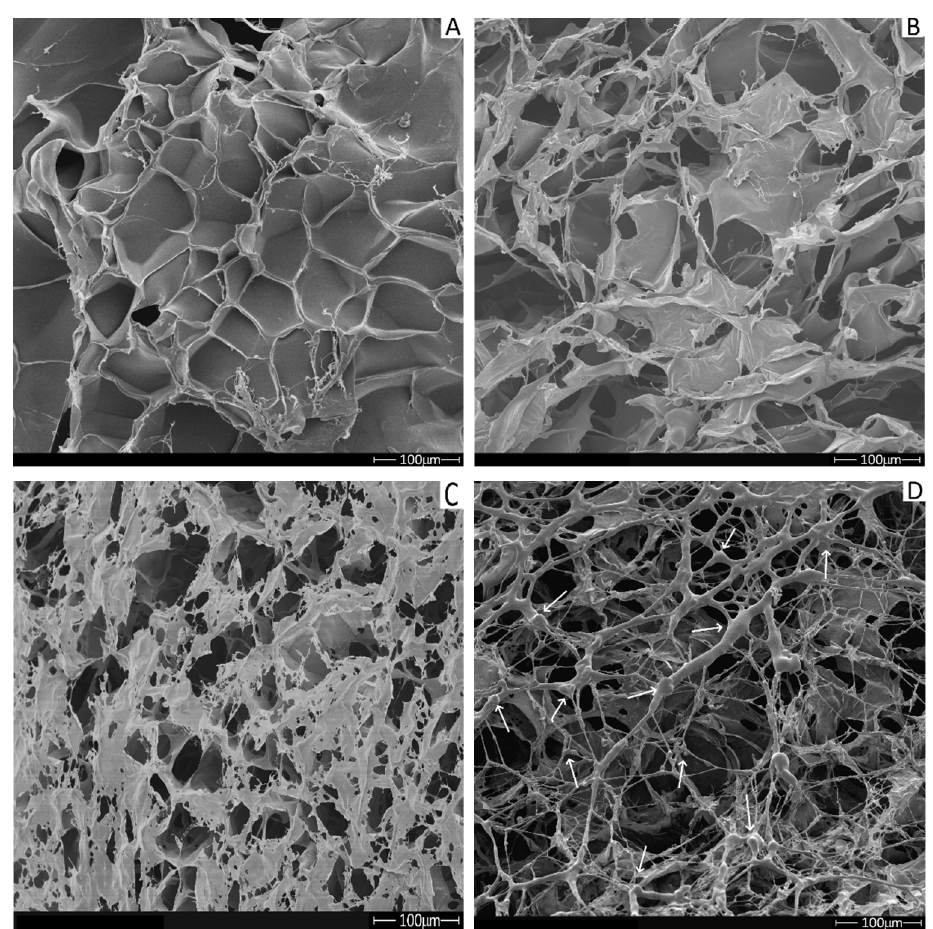
Figure 8. SEM Micrographs of collagen scaffold before and after phosphorylation. ( A ) C, ( B ) CP, ( C ) C10P, ( D ) C30P. Magnification of 200×.